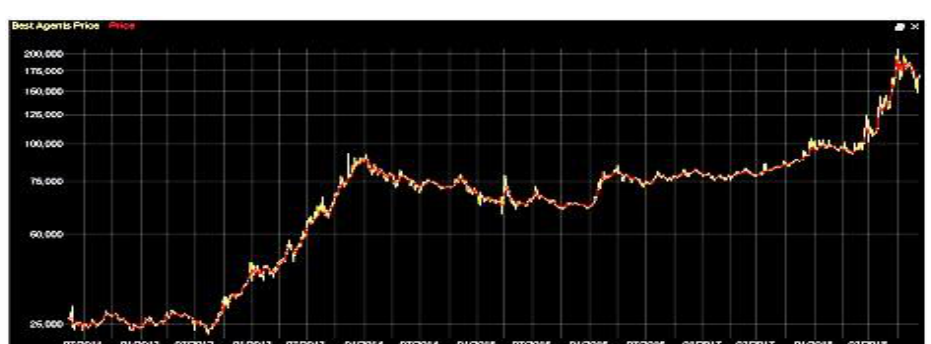
Fig.3. Time series plot of “TEPIX” at 10% best agents group size; the red curve is the historical “TEPIX” quotes; the yellow is the series estimated by gents